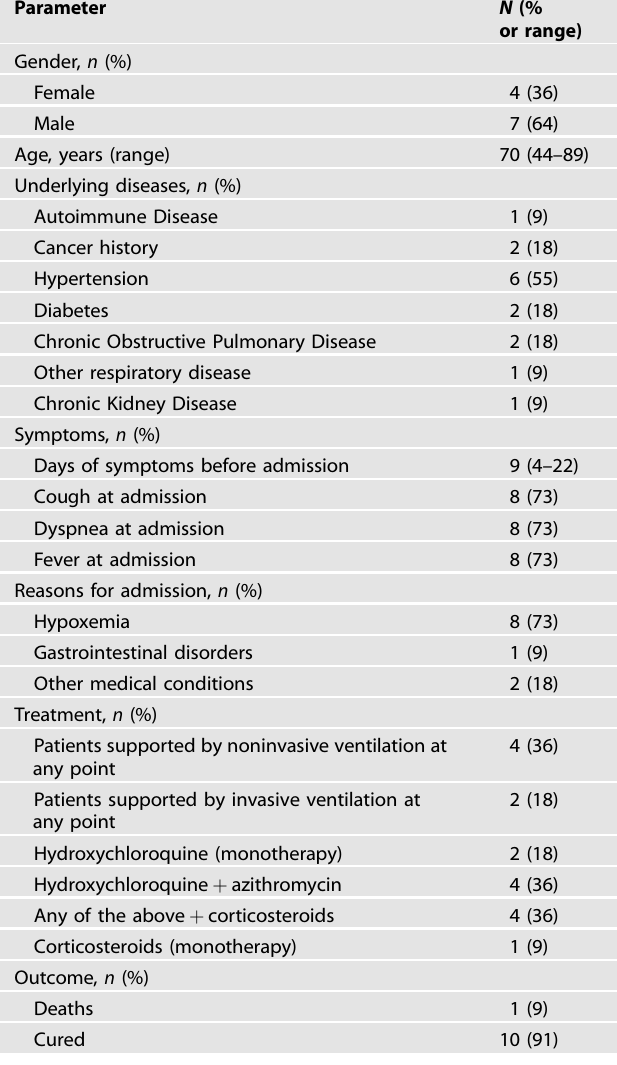
Table 2. Clinical characterization of patients monitored during the acute phase of